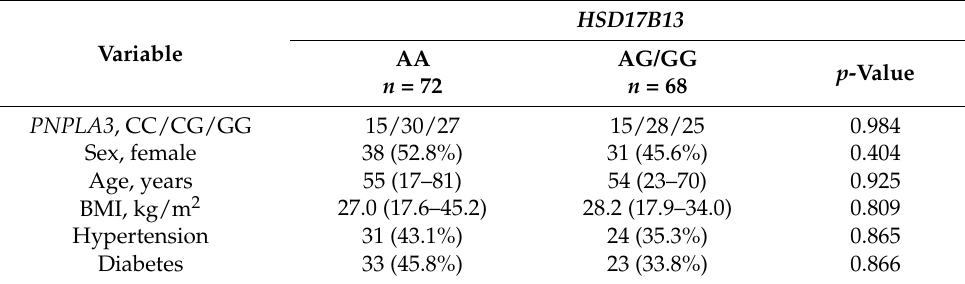
Table 2. Characteristics of the NAFLD patients according to the HSD17B13